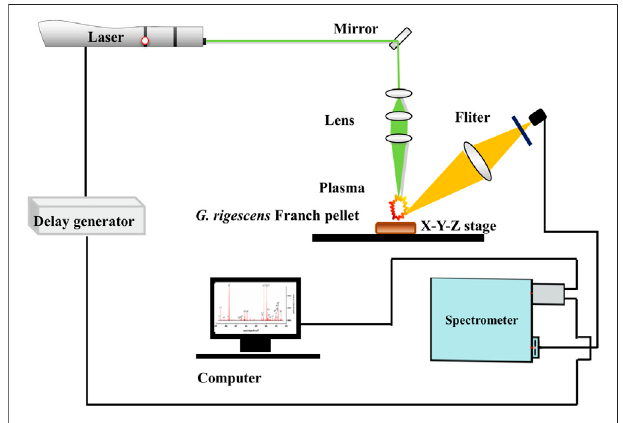
FIGURE 1 | The schematic diagram of the laser-induced breakdown spectroscopy (LIBS)